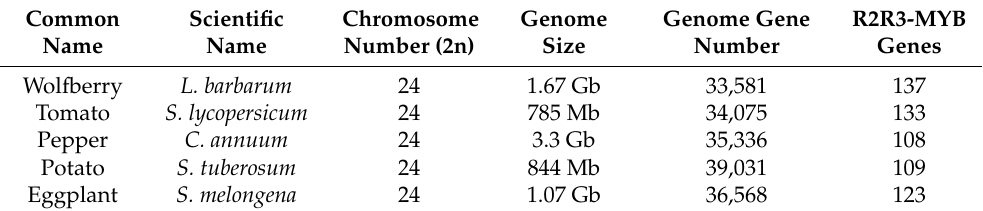
Table 1. Genomic information and identified R2R3-MYB gene numbers in five Solanaceae species.